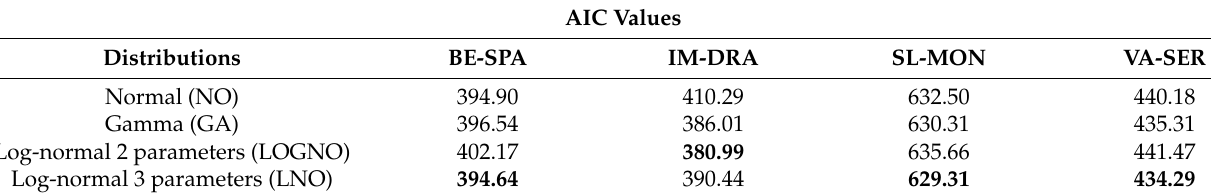
Table 2. AIC values for all the considered distributions of the stationary analysis. In bold are shown the lowest AIC values among the analyzed distributions for each station.